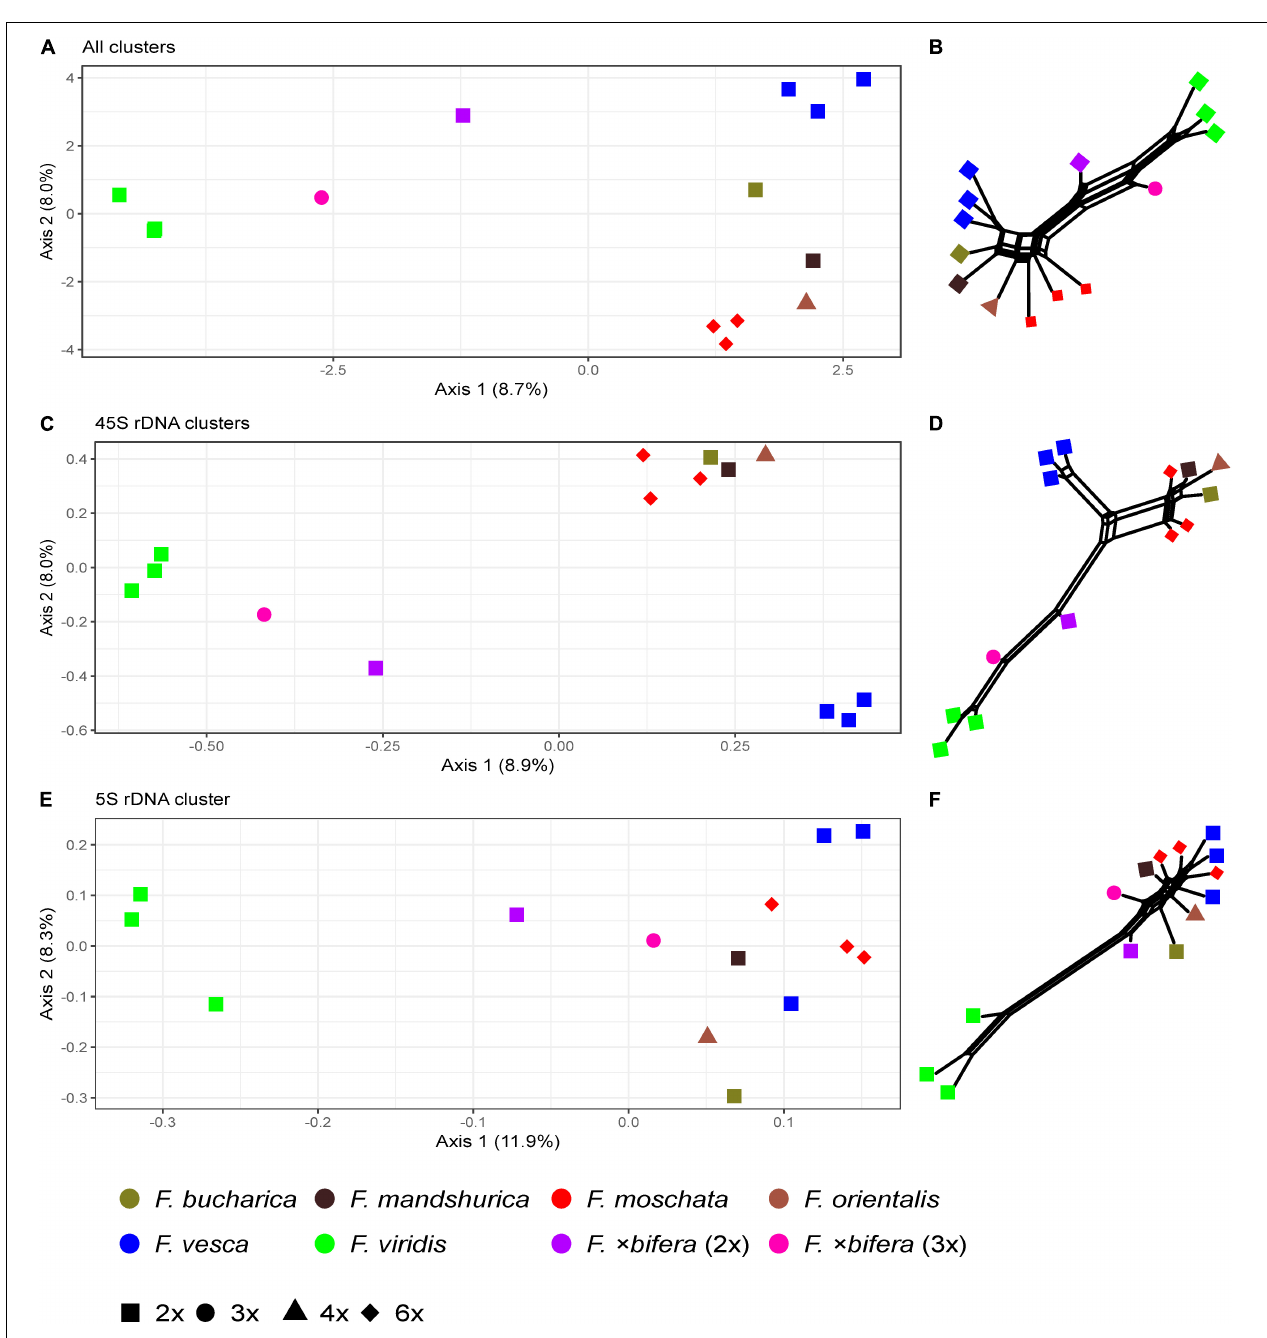
FIGURE 5 | Principal Coordinate Analyses of Fragaria species based on the inverted and summarized observed/expected matrices from comparative RepeatExplorer2 output and neighbor nets based on Gower distances calculated from those comparative RepeatExplorer2 outputs. Axis percentage explains the variance on the first two dimensions. (A) PCoA and (B) the neighbor net across all 352 clusters, (C,D) across seven clusters containing 45S rDNA, and (E,F) Cluster 188 containing 5S rDNA